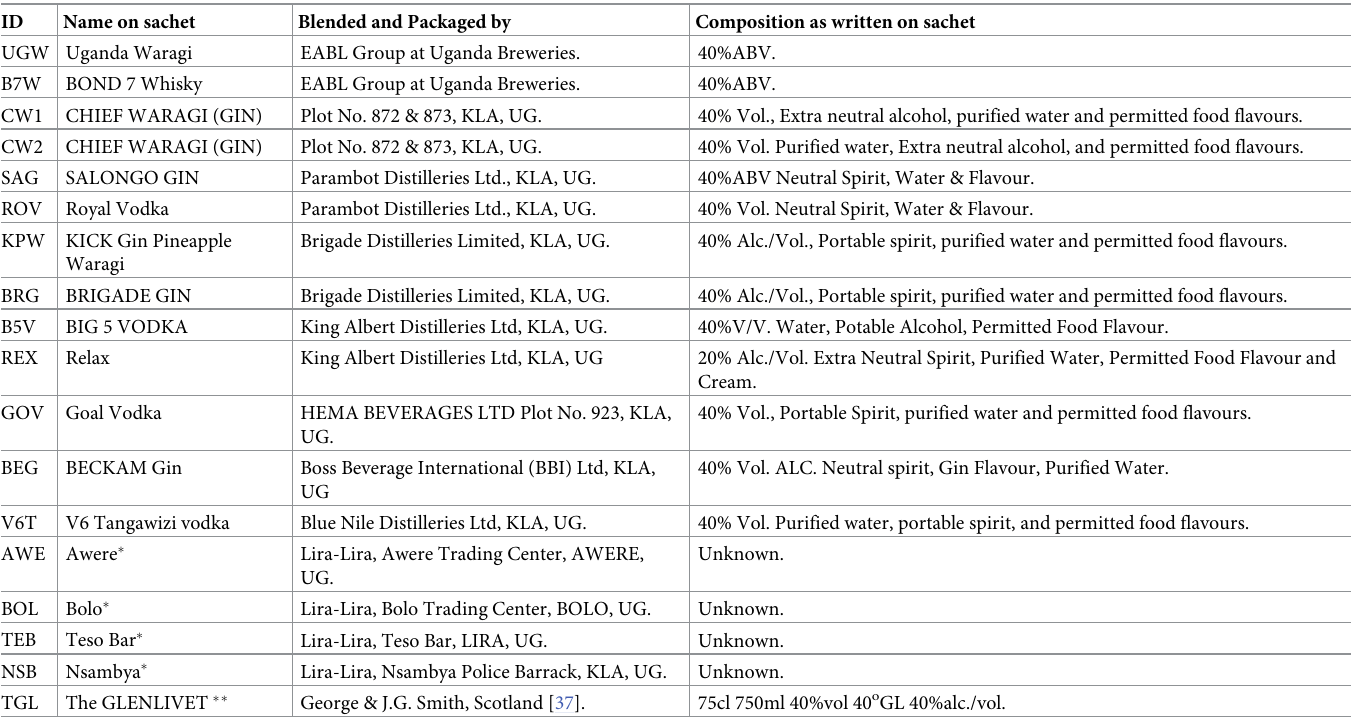
Table 1. Description of the alcohol samples used in this